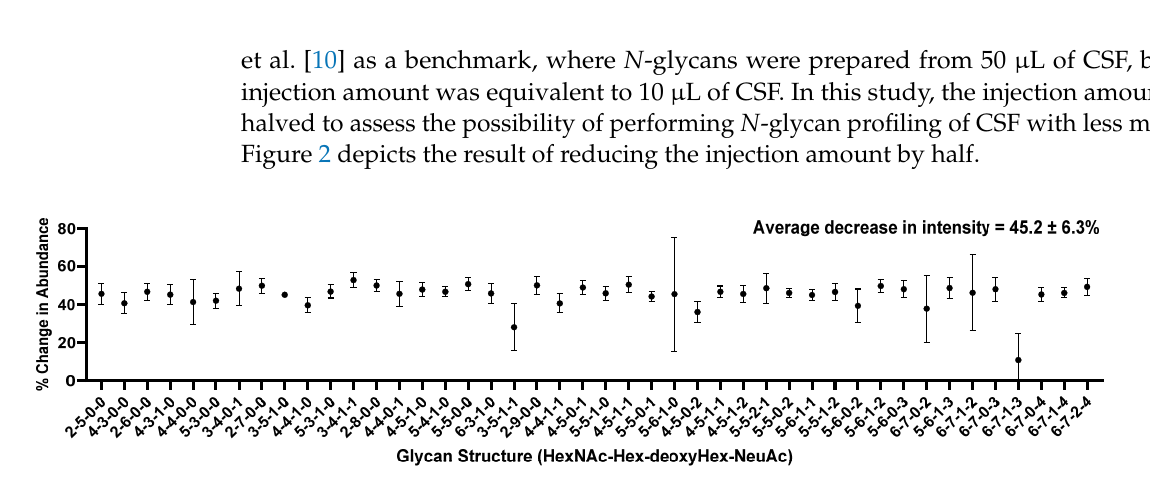
Figure 2. Scatter plot showing decrease in instrument signal as a result of reducing the injection amount from 10 μ L of cerebrospinal fluid (CSF) to 5 μ L of CSF. As expected, the signal was reduced by nearly half.